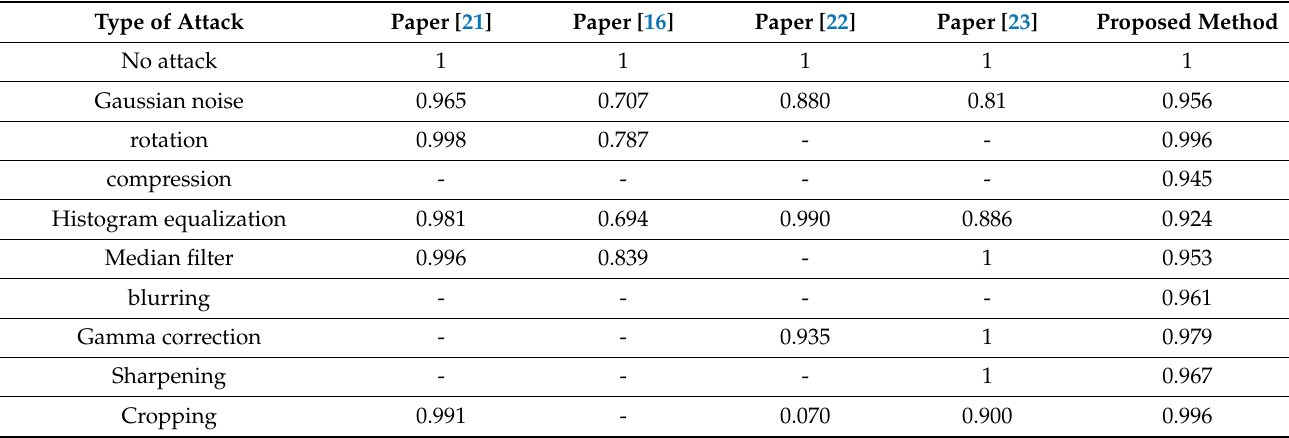
Table 8. NC comparison against various attacks of proposed method with existing